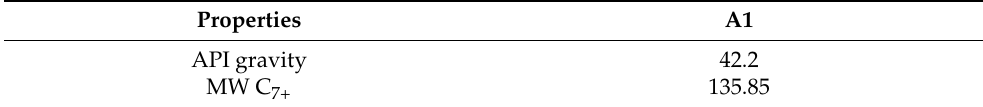
Table 1. Crude oil sample properties.